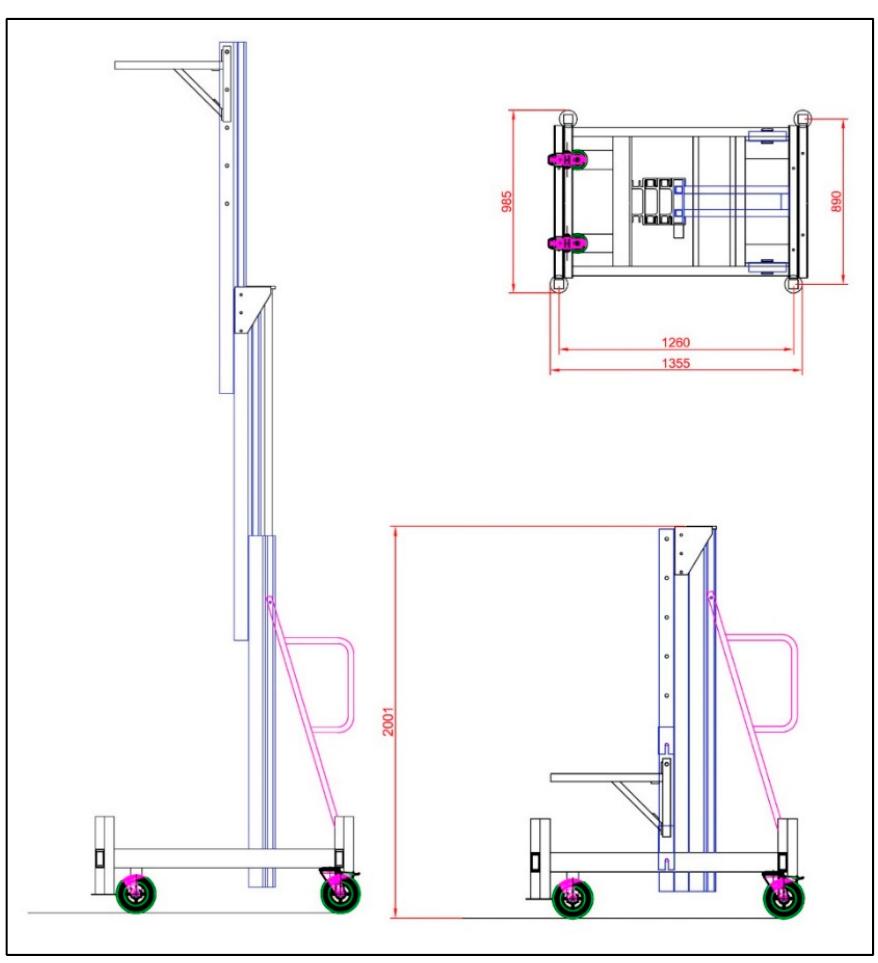
Figure 4. Gantry’s scheme and sizes.